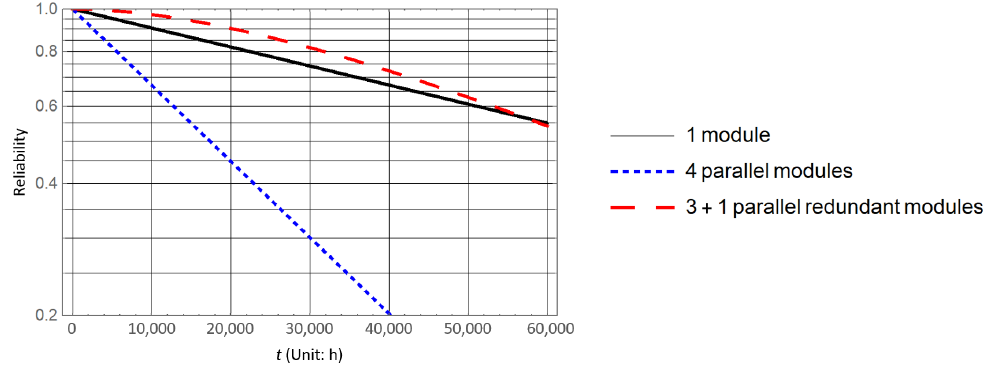
Figure 2. Comparison of the reliability of the N + 1 charging system over